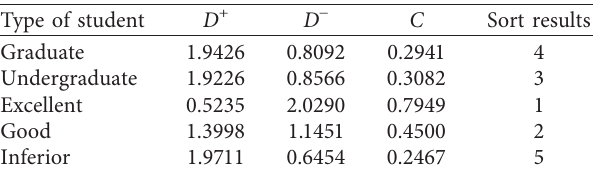
Table 4: C value of students’ emergency ability and the result of ranking emergency